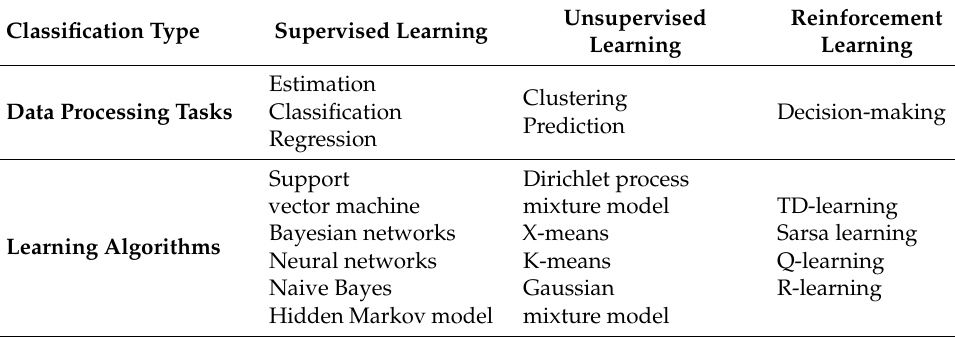
Table 1. Main Machine Learning (ML) techniques. Classification Type Supervised Learning Data Processing Tasks Learning Algorithms